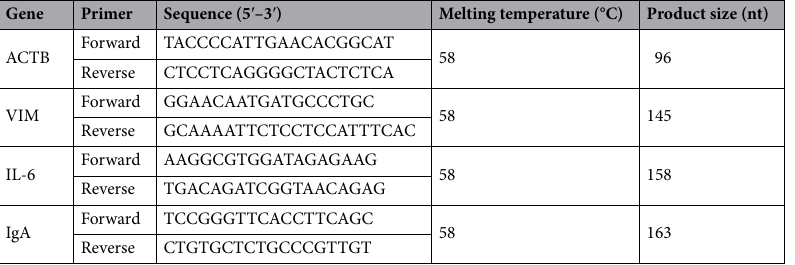
Table 9. Genes and primers used in the study. ACTB: B-actin; VIM: vimentin; IL-6: interleukin 6; IgA: immunoglobulin